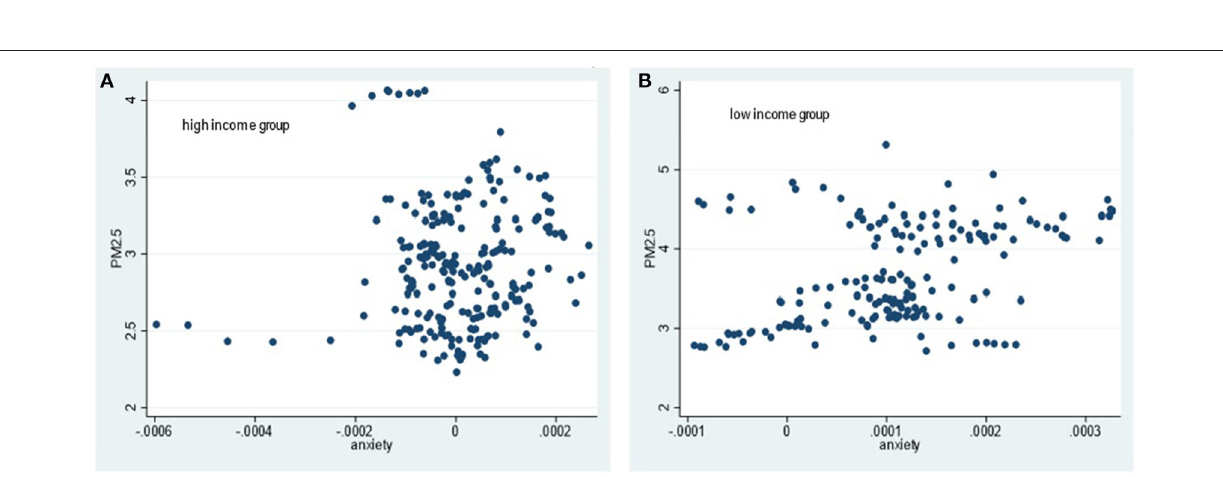
FIGURE 3 | Scatter diagram of relationship between PM2.5 concentration and anxiety in different income groups. (A) High income group. (B) Low income group.